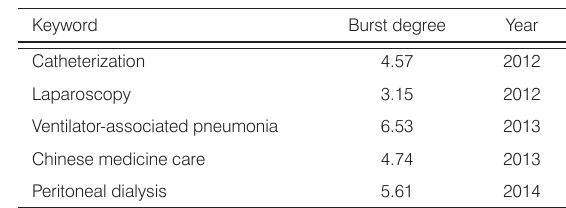
Table 3. Burst degree and burst year